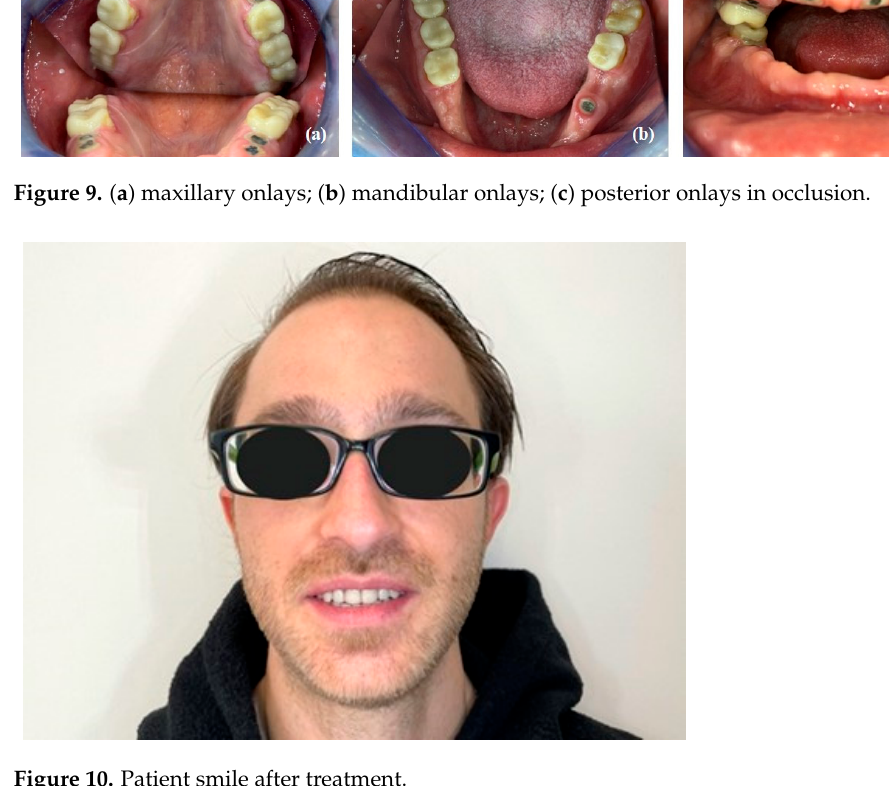
Figure 10 . Patient smile after treatment. Figure 10. Patient smile after